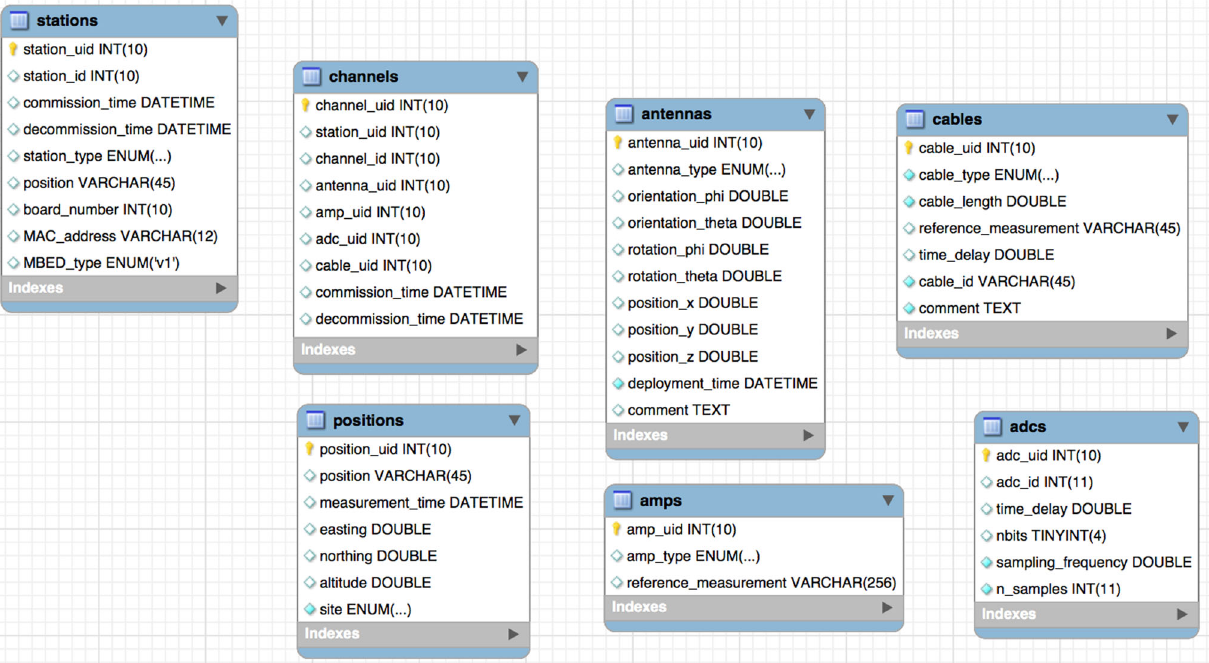
Fig. 3 MySQL database layout for the time-dependent detector description as used in